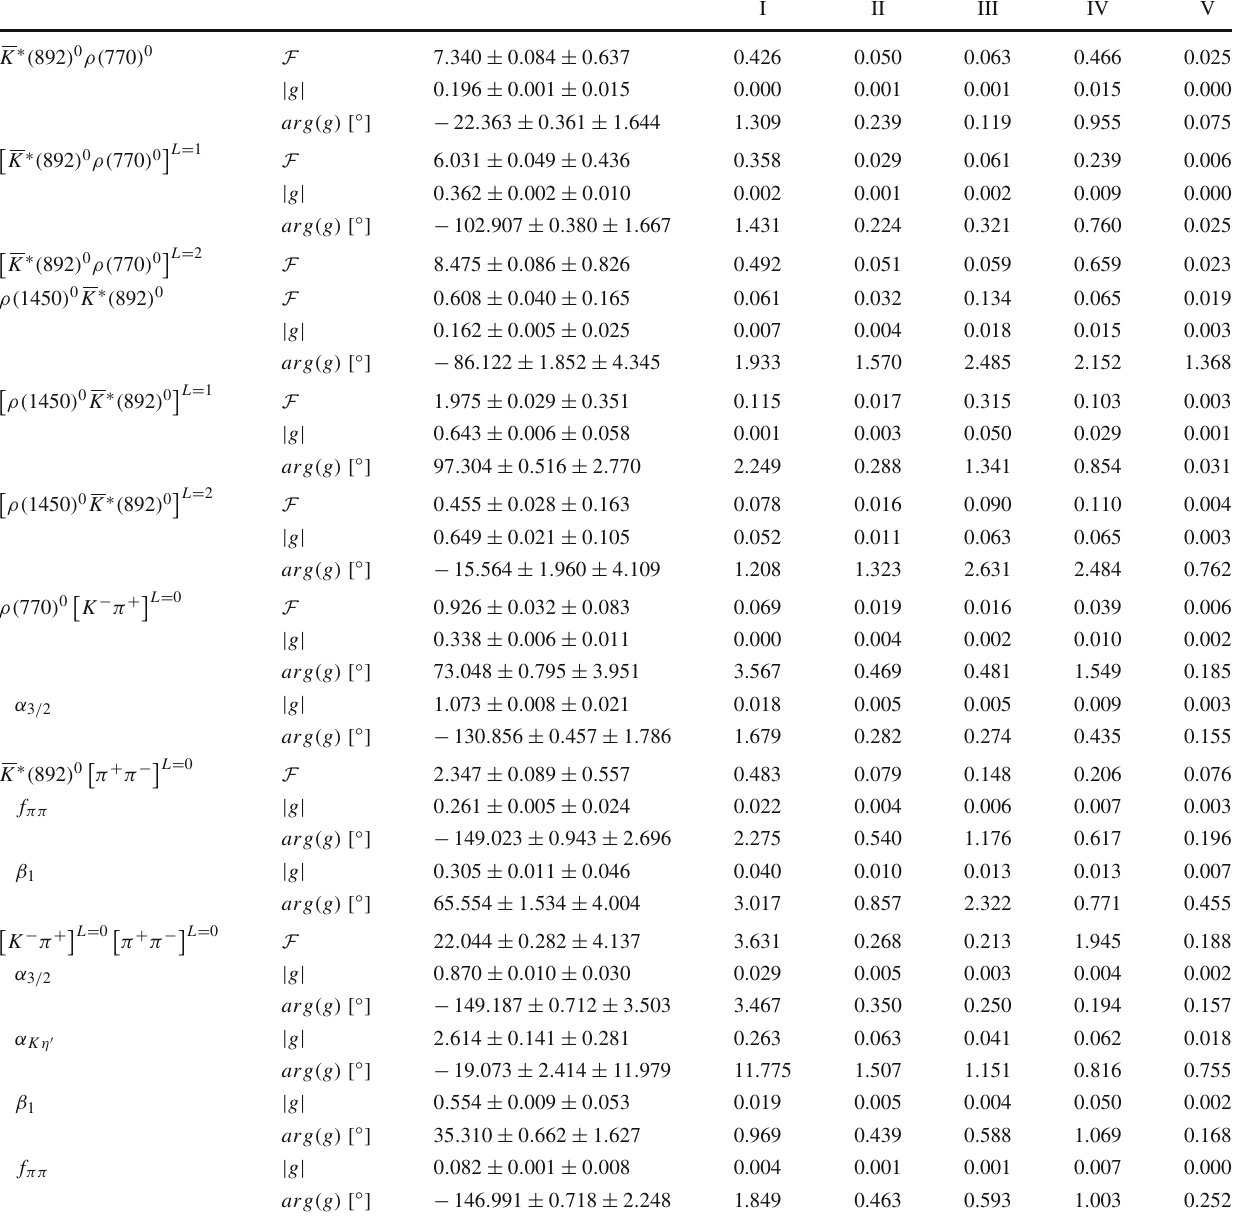
Table 14 Systematic uncertainties on the RS decay coupling parameters and fit fractions for quasi two-body decay chains